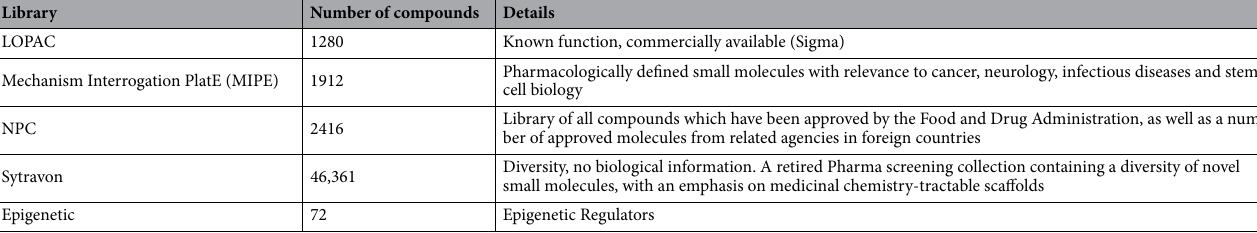
Table 1. Compound libraries used in this study.